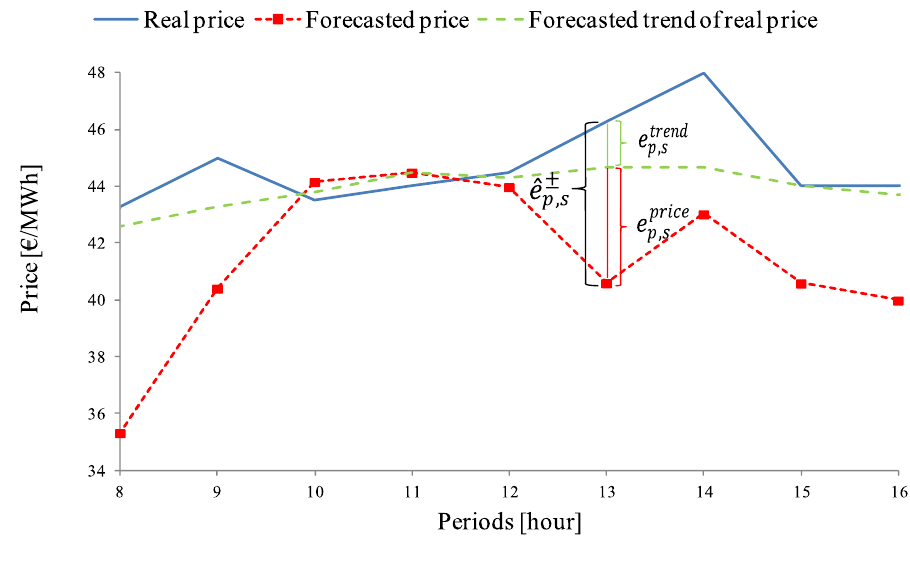
Figure 10. Description of ˆ e ± p , s